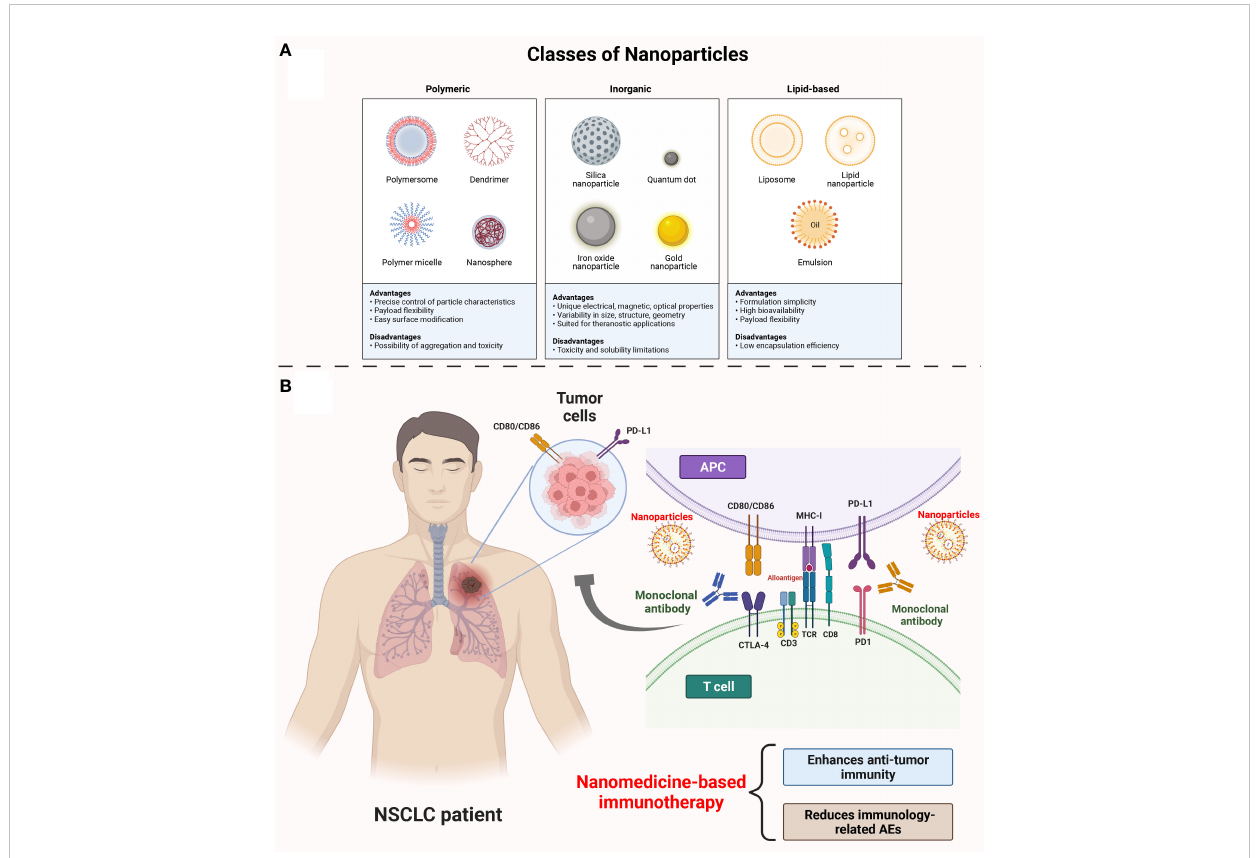
FIGURE 1 The mechanisms of nanoparticles medicine in NSCLC immunotherapy. (A) Classes of nanoparticles. Mainly, there are three classes of nanoparticles: polymeric, inorganic, lipid-based nanoparticles. The polymeric nanoparticles are precise control of particle characteristics, payload fl exibility and with easy surface modi fi cation. The inorganic nanoparticles are unique, electrical, magnetic, optical properties. They can be visualized in size, structure, geometry and they are suited for theranostic applications. The lipid-based nanoparticles are of formulation simplicity, high bioactivity and payload fl exibility. (B) Nanoparticles loading ICIs monoclonal antibody in NSCLC treatment. Administration of ICIs leads to the activation of tumor-speci fi c T cells (always CD8+ T cells) activation by blocking PD-1 and CTLA-4 on T cells, and PD-L1 and CD80/86 on APC/tumor cells as well. The use of ICIs along will over-stimulate the immune system and increase the potential of off-target effects which is the source of systematic AEs. Specially, nanoparticles loading ICIs can lead to a high local concentration of ICIs on the tumor region while reducing the off-target effects from ICIs. NSCLC, non-small cell lung cancer; ICIs, immune checkpoint inhibitors; PD-1, programmed cell death 1; CTLA-4, cytotoxic T-lymphocyte – associated antigen; PD-L1, programmed cell death ligand 1; APC, antigen processing cell; AEs, adverse